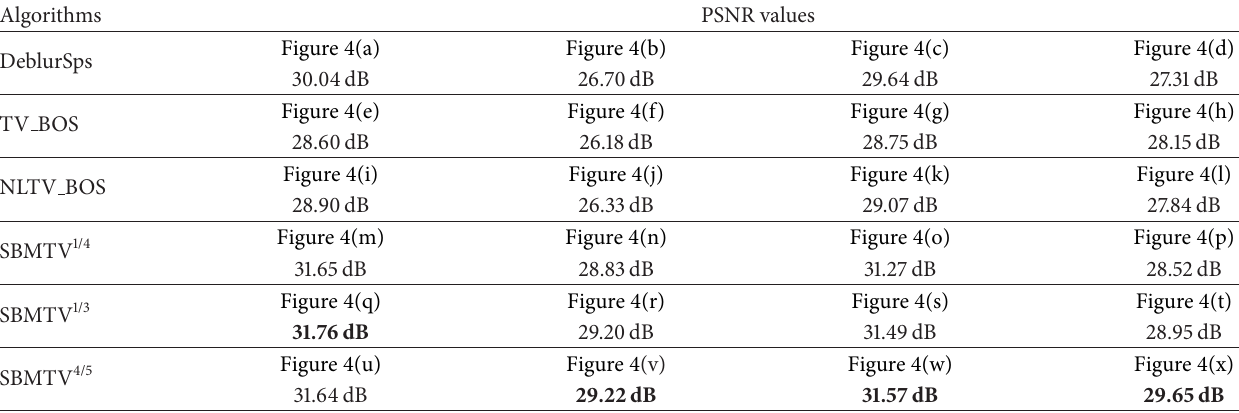
Table 4: PSNRs of images in Figure 4.